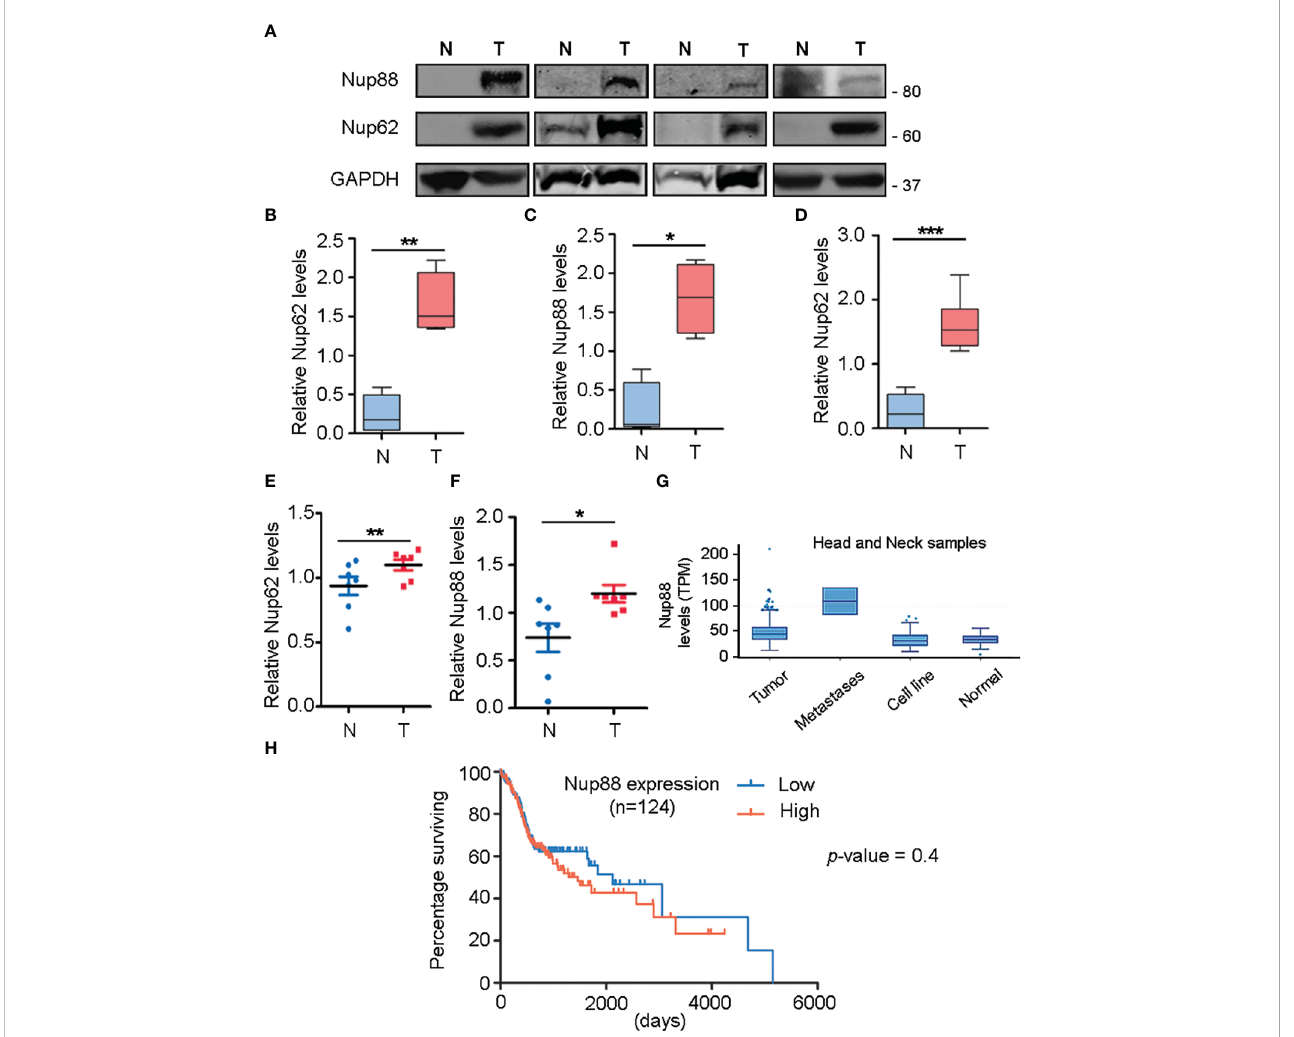
FIGURE 1 Nup88 and Nup62 are overexpressed in oral cancer. (A) Western blot analysis of lysates prepared from oral cancer patient tissues using antibodies against Nup88, Nup62, and GAPDH. (B, C) Quanti fi cation of Nup62 and Nup88 band intensities relative to GAPDH protein levels from normal and tumor tissues, shown in (A) . (D) Nup62 protein levels relative to GAPDH in oral cancer tissues (n=10) (N= Adjacent normal tissues, and T= Tumor). The asterisk represents the signi fi cance value. Values on the y-axis represent data obtained by normalizing with the GAPDH band intensity. The asterisk indicates statistical signi fi cance p<0.05. (E, F) Graphs indicate fold changes in Nup62 and Nup88 mRNA levels, respectively, in oral cancer tissue samples (n=7). Y- axis values indicate Nups level relative to Rps16 control levels. (G) Nup88 expression in TCGA head and neck statistics analyzed in Mi-Panda. (H) Kaplan- Meier survival curve for Nup88 using OncoLnc on oral cancer TCGA data. (Student ’ s t-test - paired t-test) *p < 0.05, **p < 0.01 and ***p <